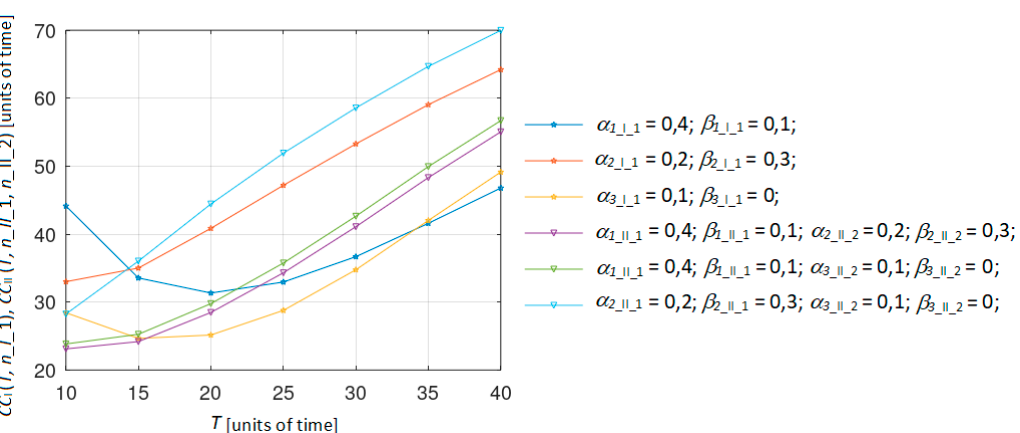
Figure 8. The expected cost per unit of time for the inspection interval T if the one-stage and various combinations of the two-stage policies are applied.